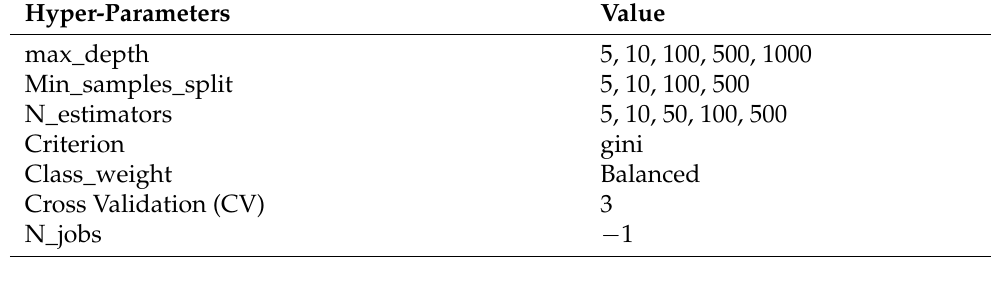
Table 5. Input Parameters for Random Forest.